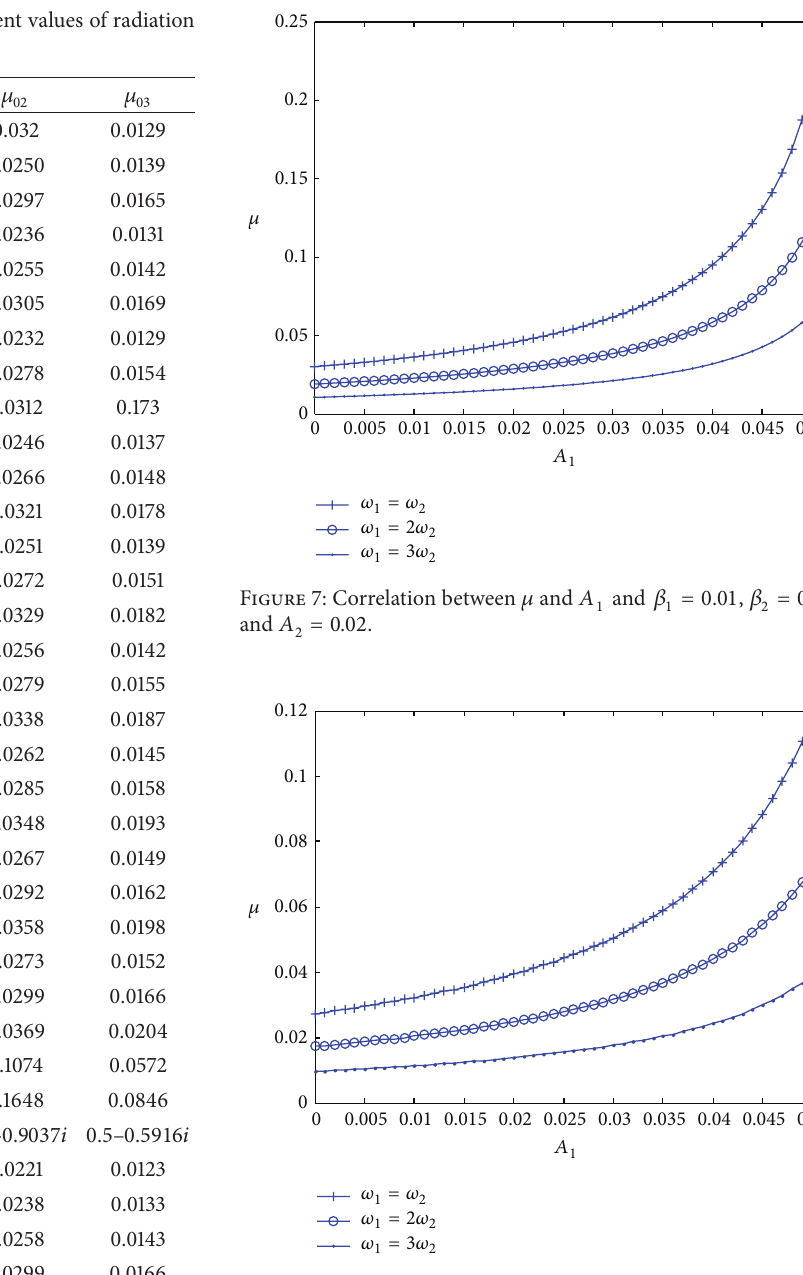
Figure 8: Correlation between 𝜇 and 𝐴 1 and 𝛽 1 = 0.01 , 𝛽 2 = 0.02 , and 𝐴 2 = 0.03